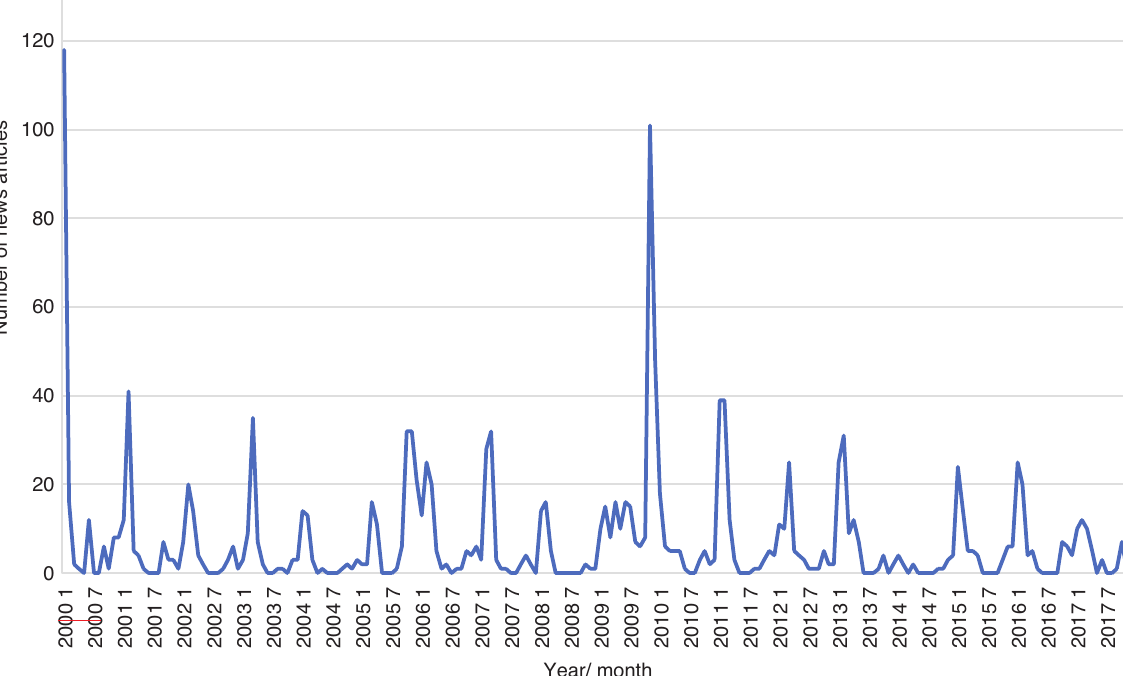
Figure 3. Problem attention cycle – influenza, 2000 –